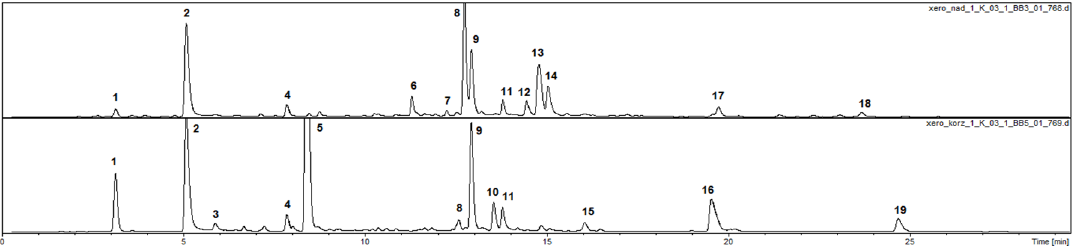
Figure 1. HPLC-DAD chromatogram of Xerolekia speciocissima extracts at a concentration of 10 mg/mL (2 μ L injected) acquired at 325 nm: upper part—aerial parts; lower part—roots. Compounds: 1 —3- O -caffeoyl quinic acid, 2 —5- O -caffeoyl quinic acid, 3 —4- O -caffeoyl quinic acid, 4 —dicaffeoyl hexaric acid, 5 —1,3-di- O -caffeoyl quinic acid, 6 —quercetin hexoside, 7 —kaempferol rhamnosylhexoside, 8 —